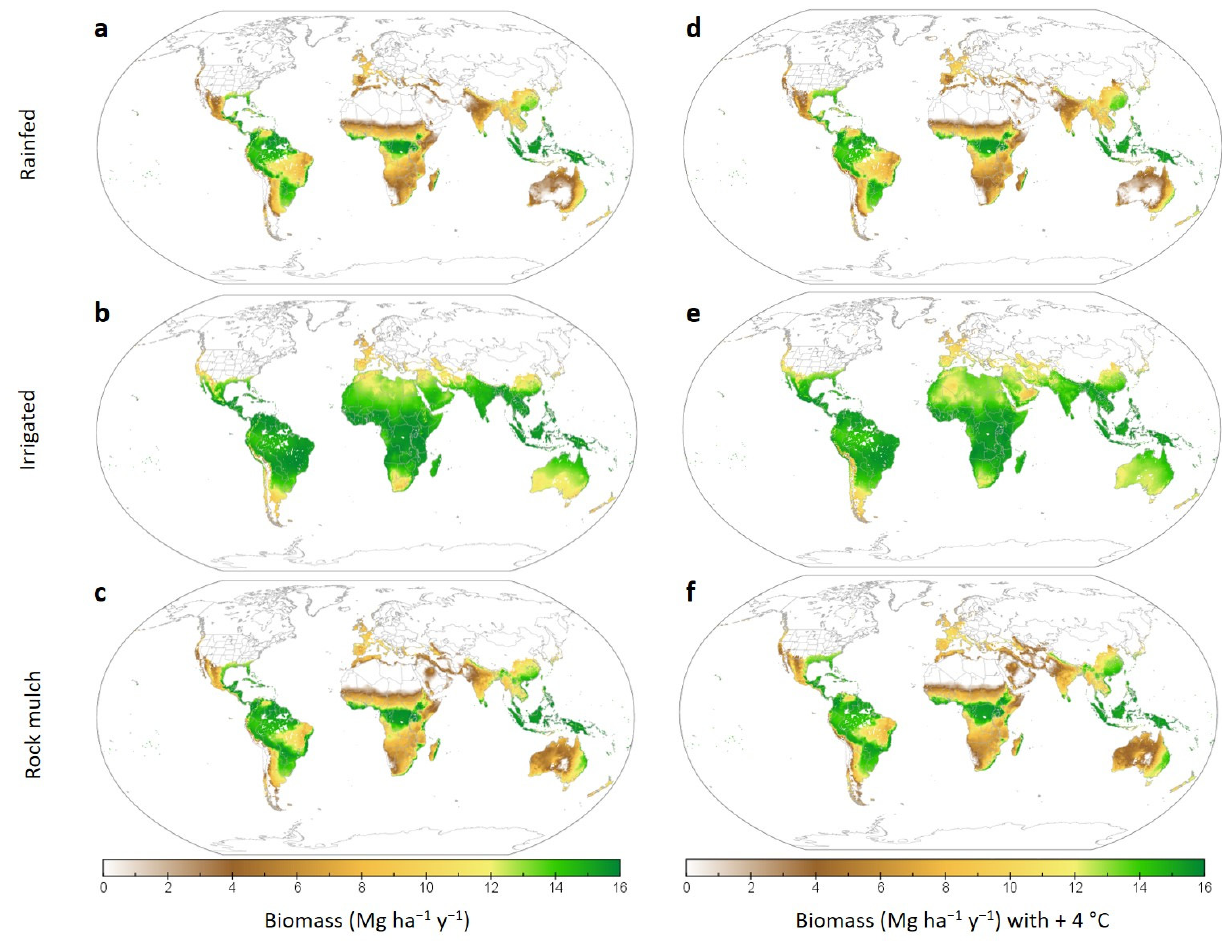
Figure 1. Spatially resolved projections of mean annual biomass production (Mg ha − 1 y − 1 ) of Agave americana over 5 years, simulated with current climate conditions ( left , a – c ) and with +4 °C warming ( right , d – f ) and in conditions with native rainfall inputs only ( a , d ), with irrigation applied to eliminate water limitation to growth ( b , e ), and with rock mulching and no irrigation ( c , f ). The rock mulch management was only simulated in locations with annual water input less than the optimum in panels c and f, but all potential land and biomass are shown on the map (inclusive of both lands without rock mulch and lands with the rock mulch that have water inputs lower that optimum) for comparison with the other simulations. Protected areas and urban areas were also removed from the area of simulation.